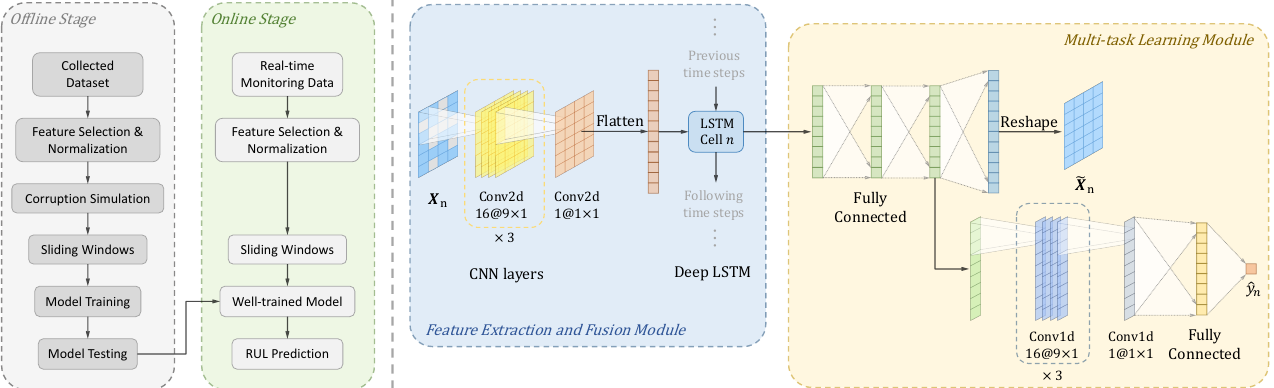
Figure 1. The left part shows the flowchart of the proposed method, and the right part shows the detailed structure of MTD-LSTM